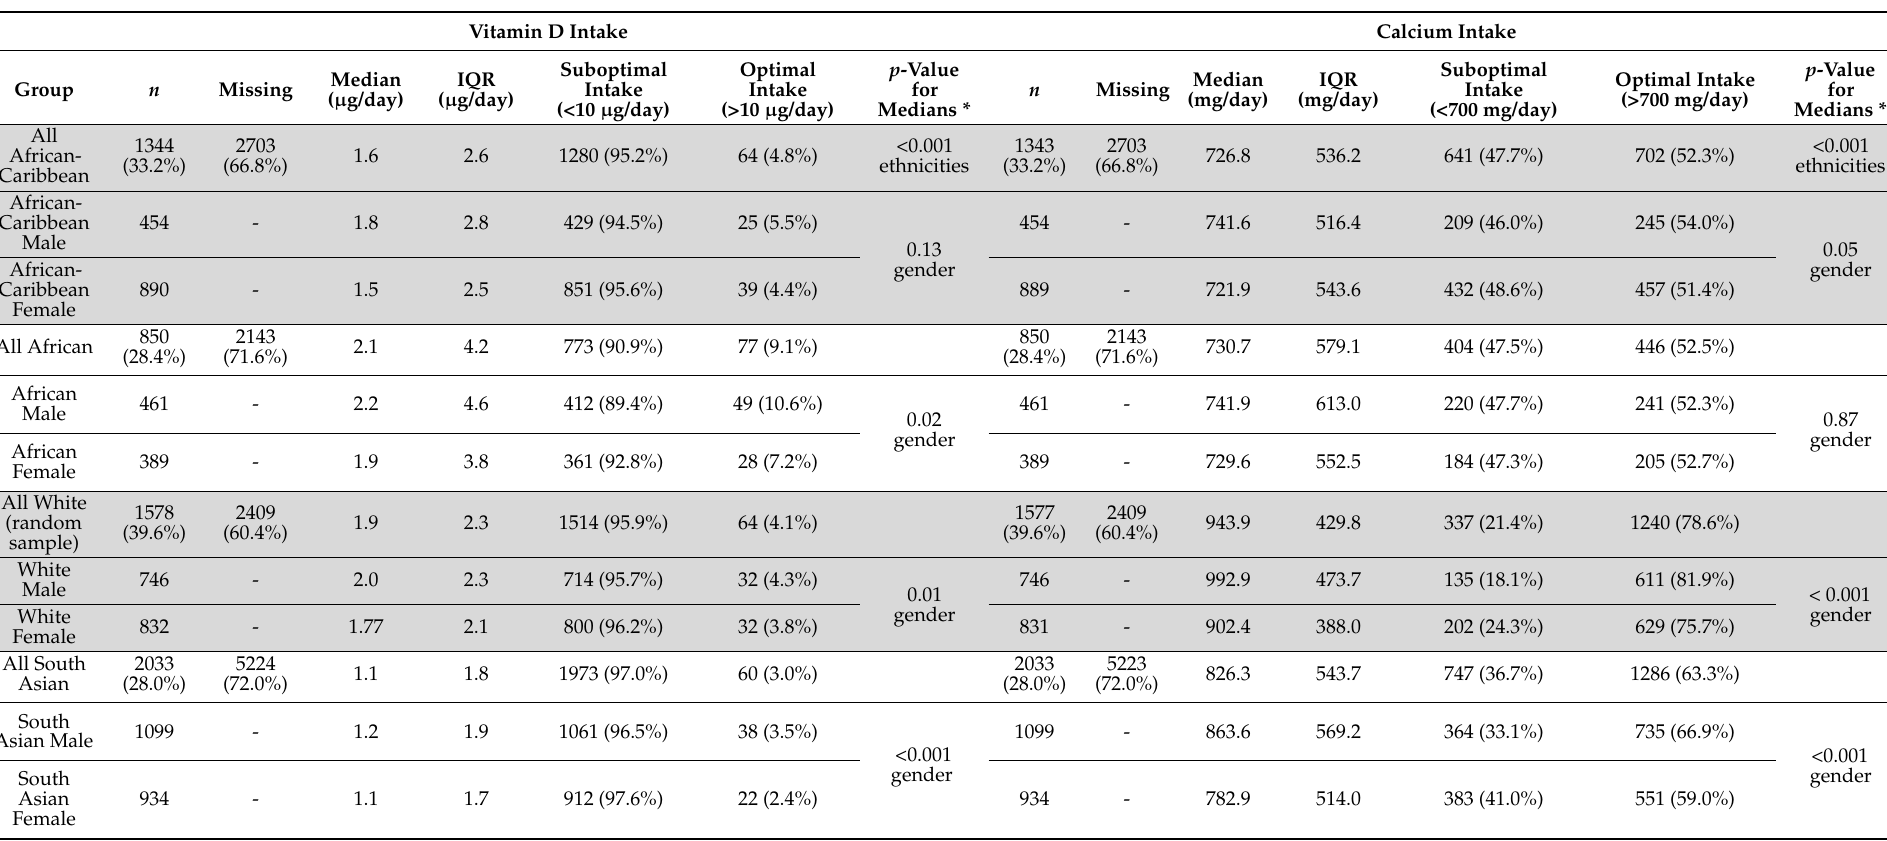
Table 6. Median and IQR values from the 24 h recall, for the vitamin D intakes ( n = 1343 African-Caribbean and n = 850 African participants with measurements) and calcium intakes ( n = 1491 African-Caribbean and n = 960 African participants with measurements) for those African-Caribbean and African participants who had a valid 25(OH)D measurement in the UK